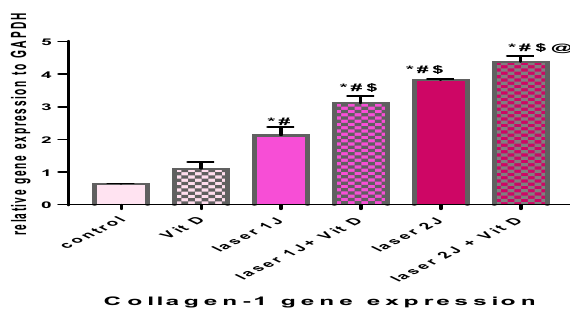
Figure 5: Col-1 gene expression showed a statistical difference between study groups (p <0.0001) with the highest values in group VI (2 J/cm 2 + vitamin D). Data were expressed as mean ± SD; P-value <0.05 was significant. (*) denotes significant difference versus control. (#) denotes significant difference versus vitamin D. ($) denotes significant difference versus laser 1 J/cm 2 . (@) denotes significant difference versus laser 1 J/cm 2 + vitamin D.